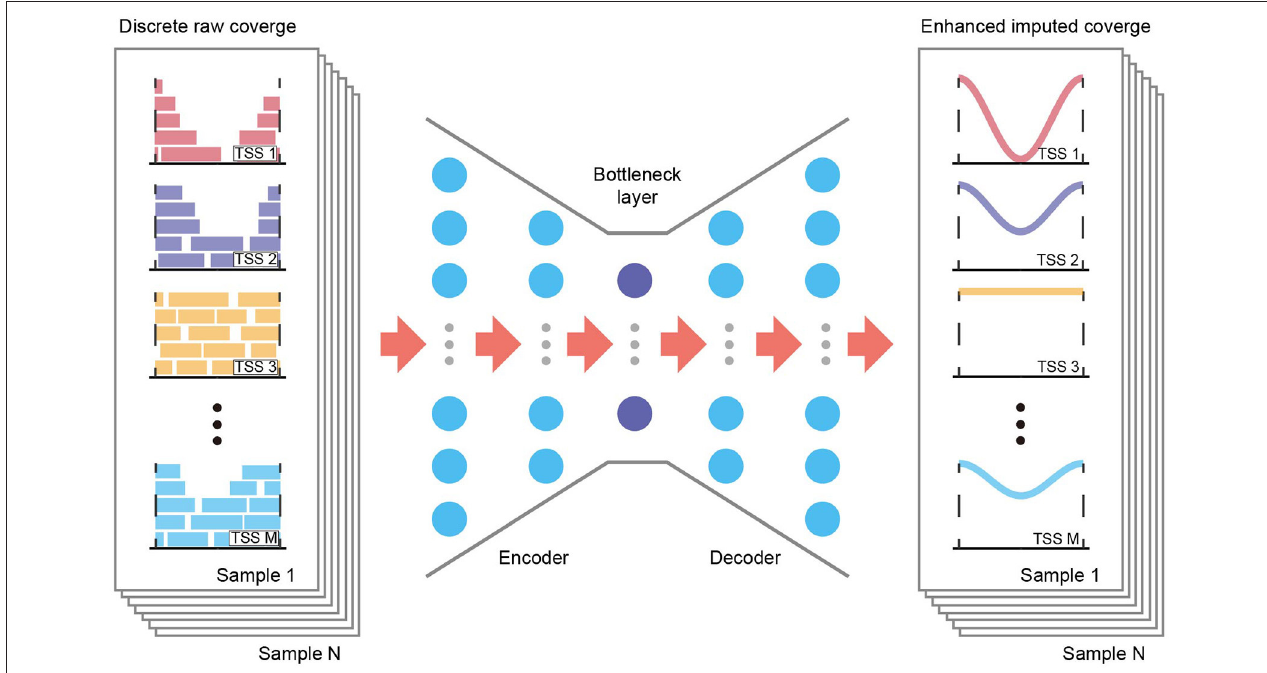
FIGURE 1 | Overview of the AECT framework. AECT is an autoencoder-based framework that has an encoder and a decoder. The autoencoder is a five-layer fully connected neural network with 128, 64, 32, 64, and 128 neurons. It uses discrete raw TSS coverage generated from shallow cfDNA sequencing data as input, and it outputs imputed coverage